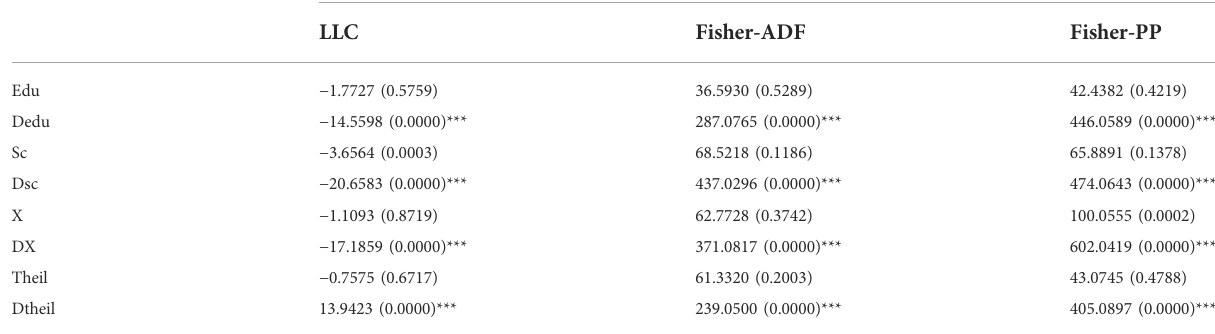
TABLE 2 Panel unit root test.